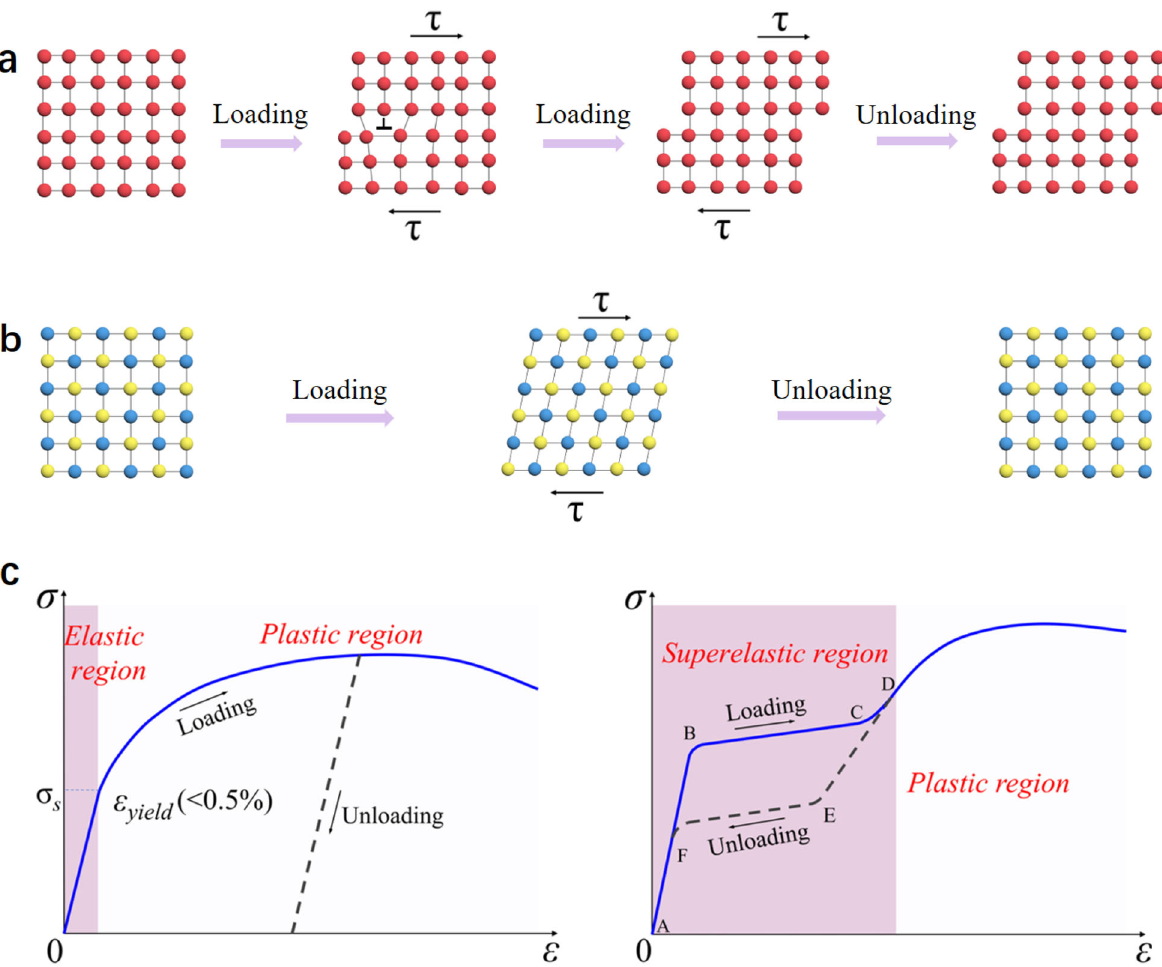
Fig. 1 Schematic diagram of deformation mechanism. Illustration of the micro-mechanism of deformation for irreversible dislocation slip for conventional metals ( a ) and reversible phase transformation for superelastic alloys ( b ), respectively. c Illustration of the elastic strain range for conventional metals (left) and superelastic shape memory alloys